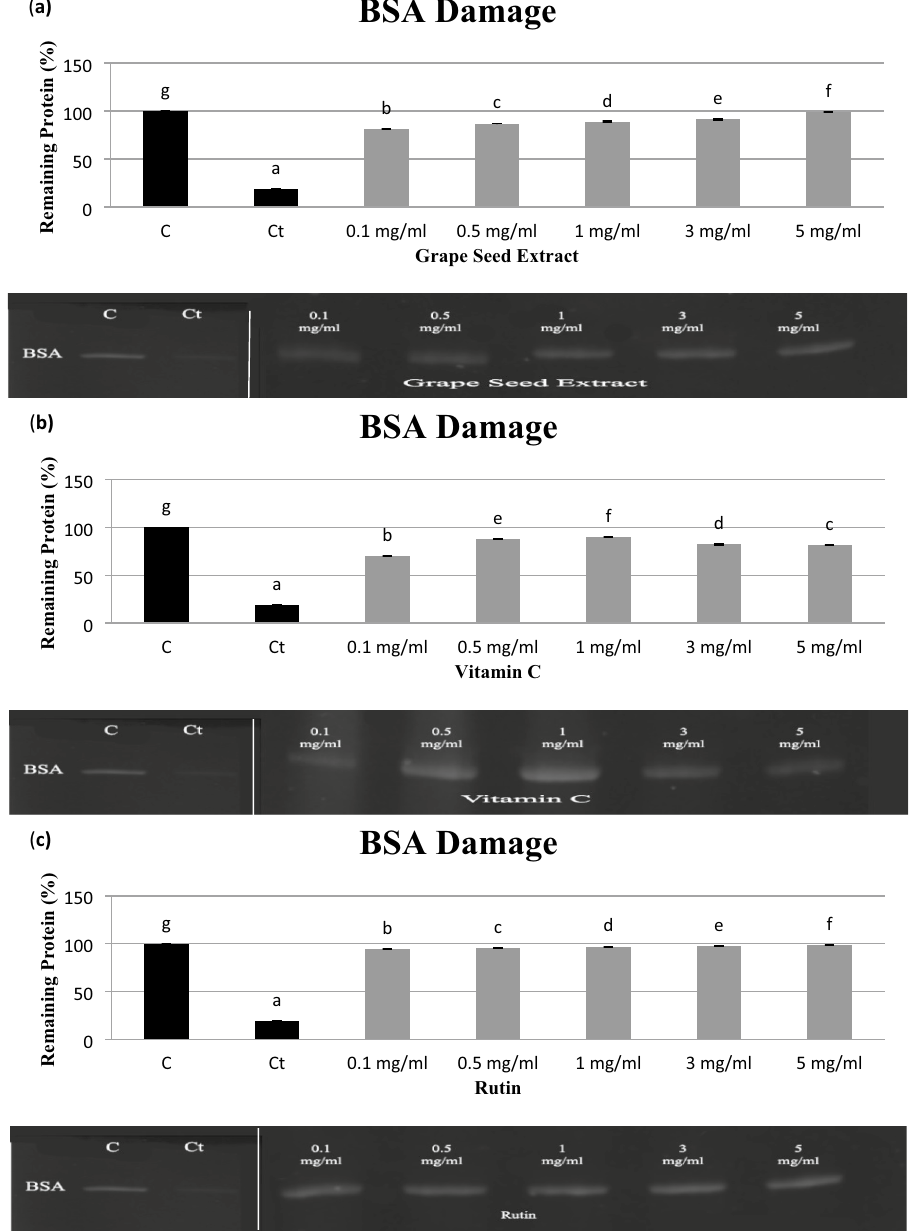
Figure 4. SDS-PAGE of the effects of ( a ) VGSE, ( b ) VC, and ( c ) rutin on the oxidative damage of BSA by AAPH. Lane 1’C’: BSA; Lane 2’Ct’: BSA + AAPH; Lane 3–7: BSA + AAPH + VGSE, VC, or rutin at different concentrations (0.1–5 mg/mL); C and Ct are cropped from a different gel. Values are means ± SD of three experiments. Different letters in the graph denote significant differences, P < 0.05. Images were captured using Image lab 4.1 software (version 6.1.0 build 7).